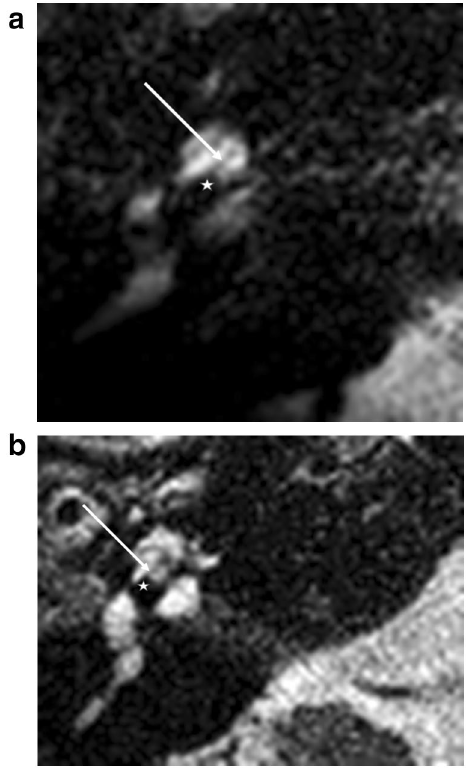
Figure 2. Straight electrodes, first turn. ( a ) Flex 28, ( b ) SlimJ. Star represents diminishing electrode signal, arrow represents basilar membrane.